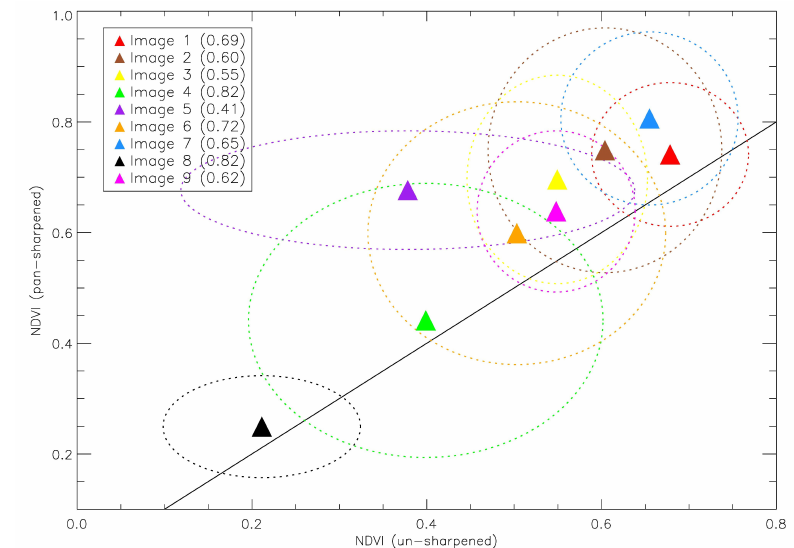
Figure 4. Comparison between the vinerow NDVI values derived from un-sharpened and pan-sharpened images. The mean values within each image are plotted as symbols (pixel counts provided in Table A2), while the dashed lines indicate the mean centered 1 standard deviation ellipses. The aspect ratio of the ellipses (semi-minor over semi-major axis length) is provided in brackets (a circle would have an aspect ratio of 1) to highlight whether the distribution of pixel values was significantly skewed by the pan-sharpening